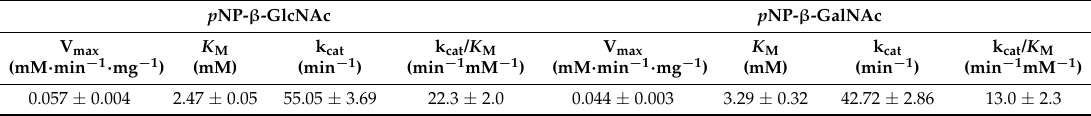
Table 1. Kinetic parameters of recombinant SnHex.